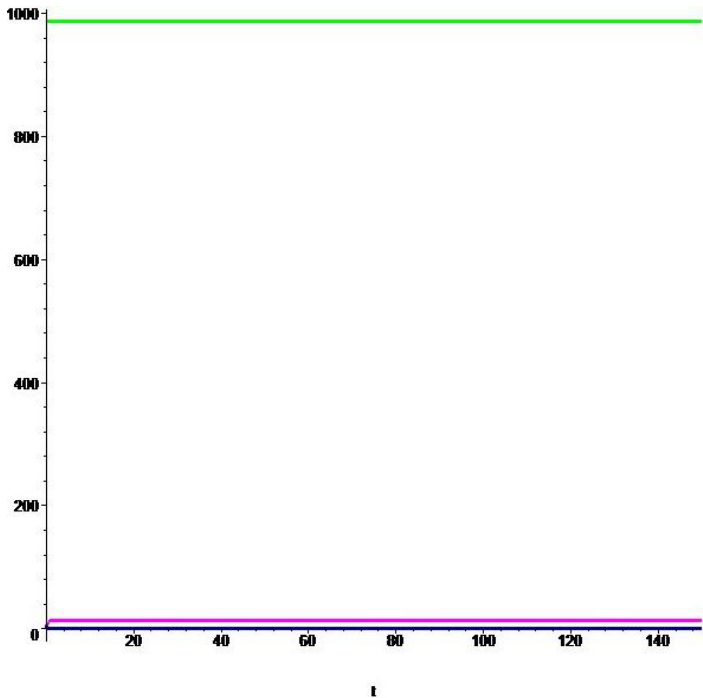
( t ) , E ( t ) , I ( t ) , R ( t ) for the Ebola outbreak ∗ ∗ ∗ ∗